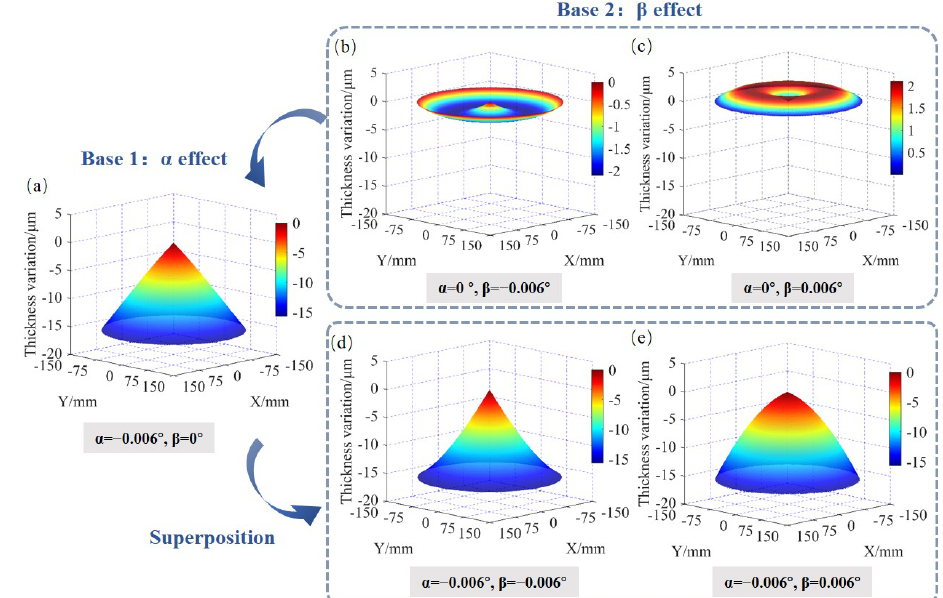
Figure 5. Wafer TTV simulation results and their topographies of under the typical space angle conditions. ( a ) α = − 0.006° and β = 0°; ( b ) α = 0° and β = − 0.006°; ( c ) α = 0° and β = 0.006°; ( d ) α = − 0.006° and β = − 0.006°; ( e ) α = − 0.006° and β =